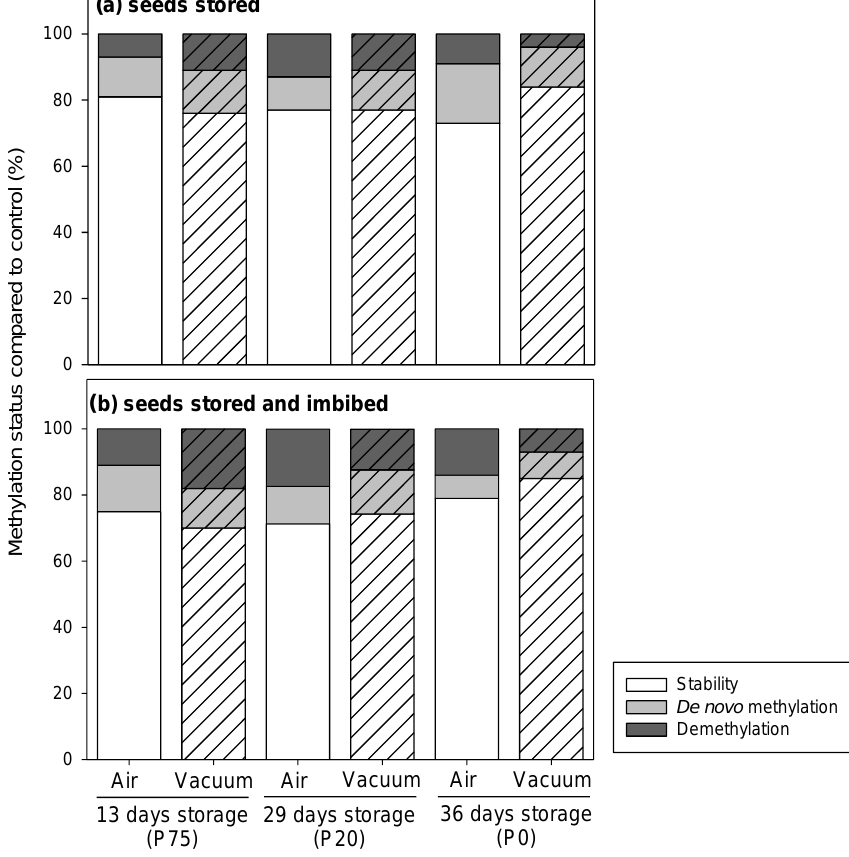
Figure 3. Percentage of stability and epigenetic changes detected in seeds of Secale cereale : ( a ) stored seeds; ( b ) stored seeds after imbibition in water. Seeds were stored at 35 °C, 15% wc under two different storage atmospheres: air (filled bars) or vacuum (striped bars). DNA was isolated from two replicates of 50 seeds per storage condition.